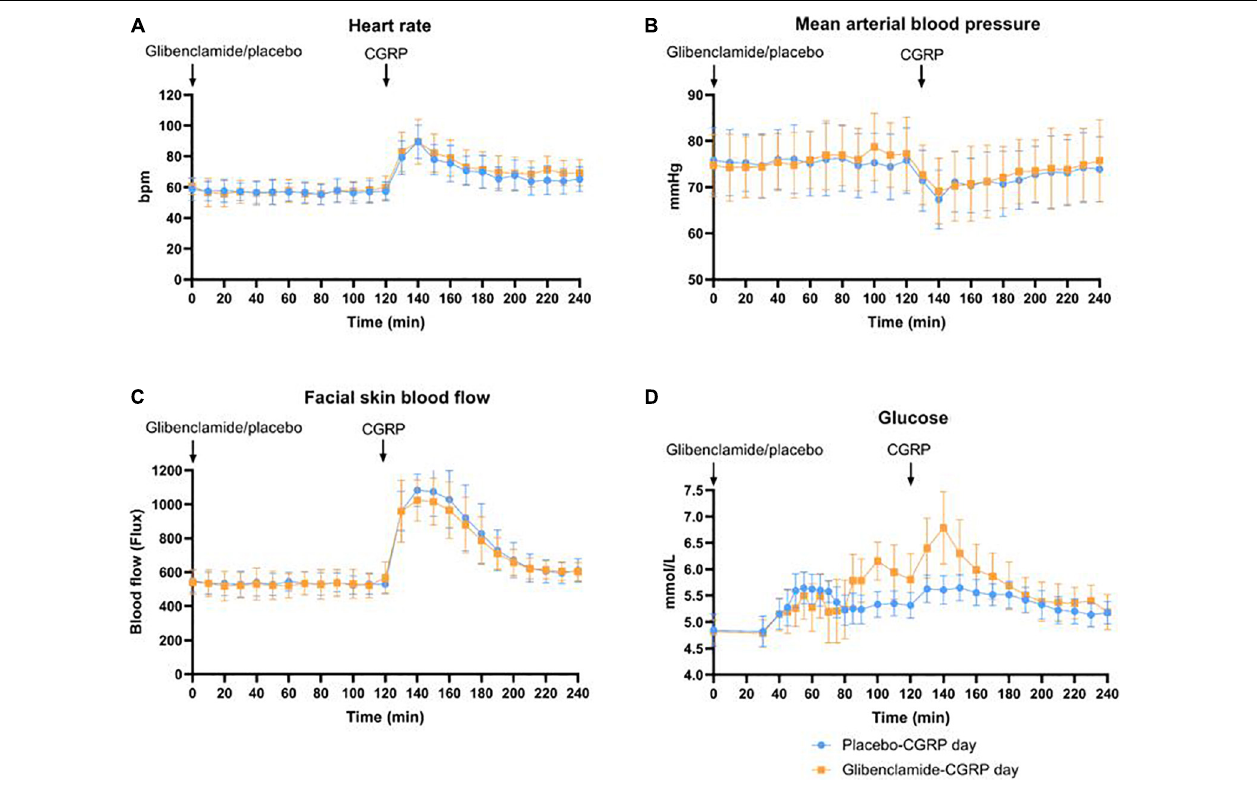
FIGURE 5 | (A) Changes in heart rate (bpm) were registered every 10 min. Heart rate did not differ between glibenclamide-CGRP and placebo-CGRP day. (B) Changes in mean arterial blood pressure (MAP) in mmHg. MAP did not differ between glibenclamide-CGRP and placebo-CGRP day. (C) Facial skin blood flow measured with Laser Speckle as changes in flux. No changes in AUC 0 − 240 min for facial skin blood flow were observed between glibenclamide-CGRP (157.5 ± 15.4) and placebo-CGRP day (160.8 ± 14.5; P = 0.3). (D) Blood glucose samples were drawn at 5 min intervals between 30 and 90 min, and at 10 min intervals hereafter. Blood glucose was clamped between 4 and 7